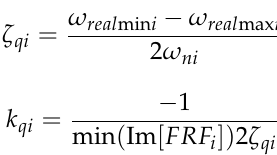
Figure 4. Relative frequency responses in the ( a ) x ‐ direction and ( b ) y ‐ direction. The peak values of real/imaginary parts were selected, and the corresponding values of frequencies in the x and y directions were applied. Consequently, the model parameters were calculated by using Equations (47)–(49).